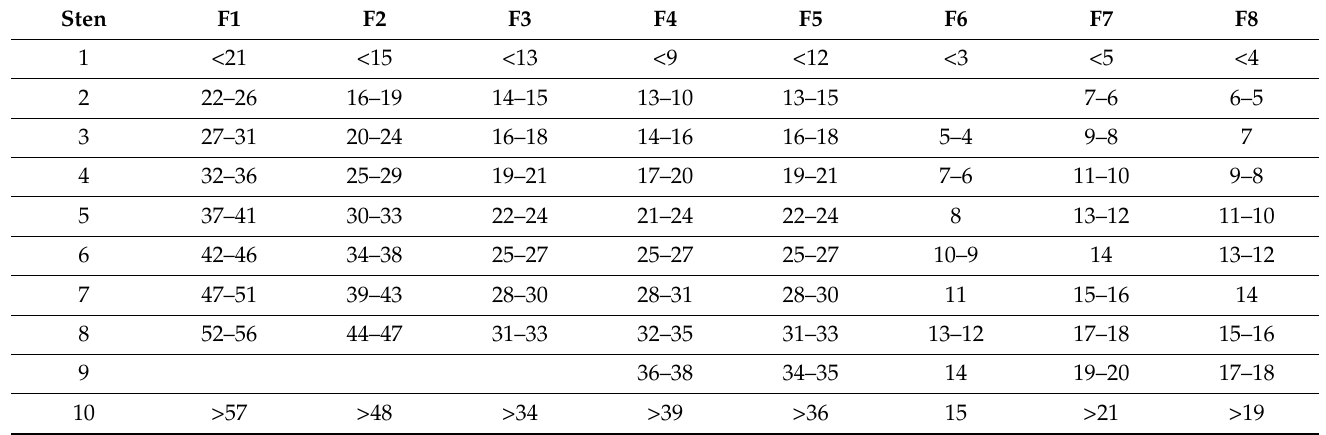
Table 8. Standards of the MBSRQ -PL questionnaire in the group of